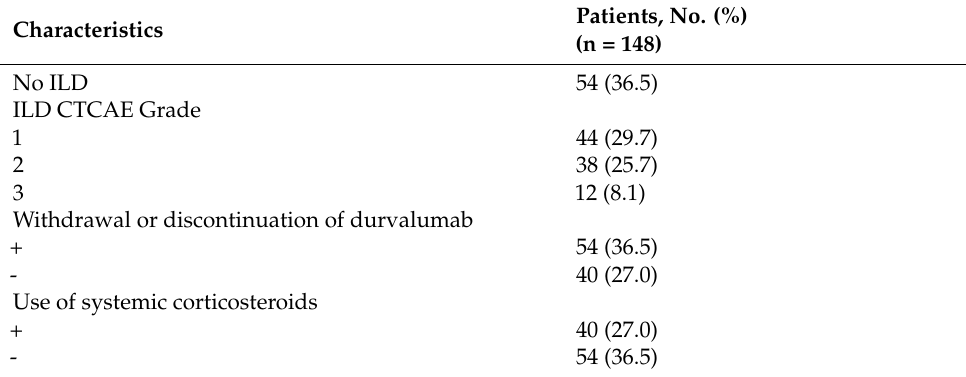
Table 2. Occurrence and severity of ILD during durvalumab